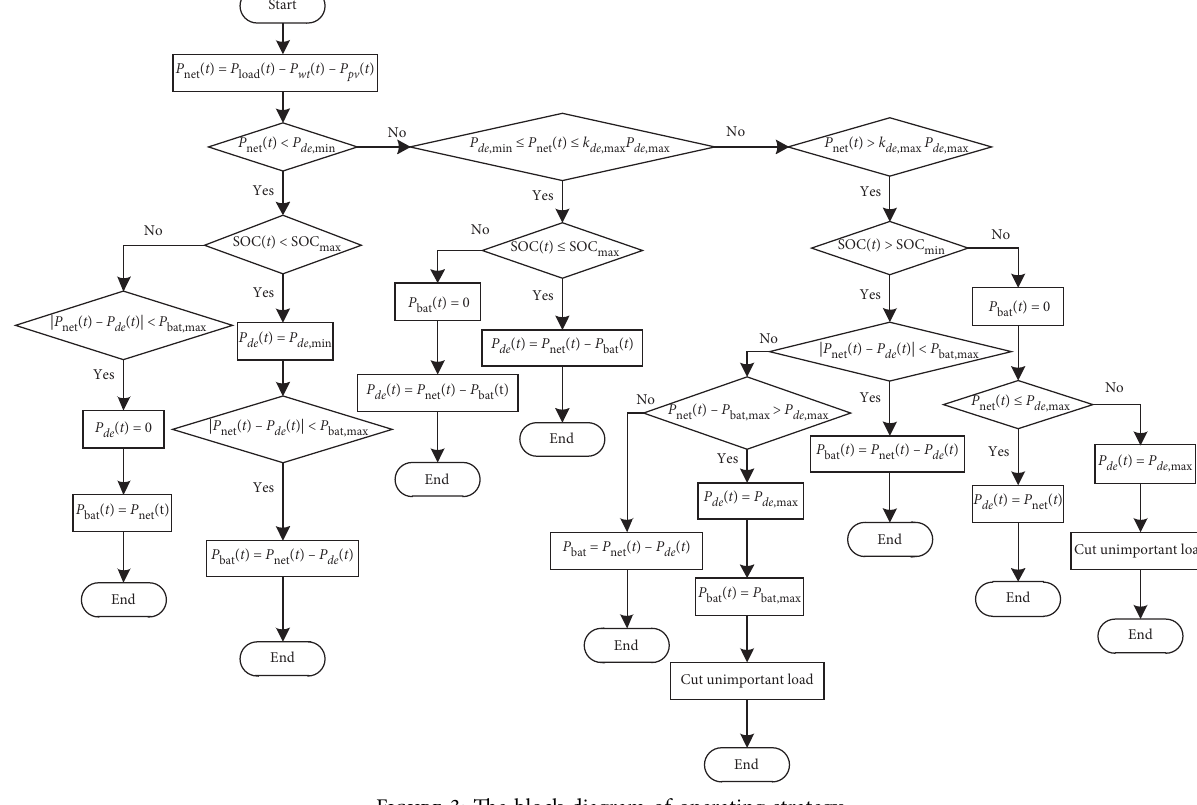
Figure 3: The block diagram of operating strategy.